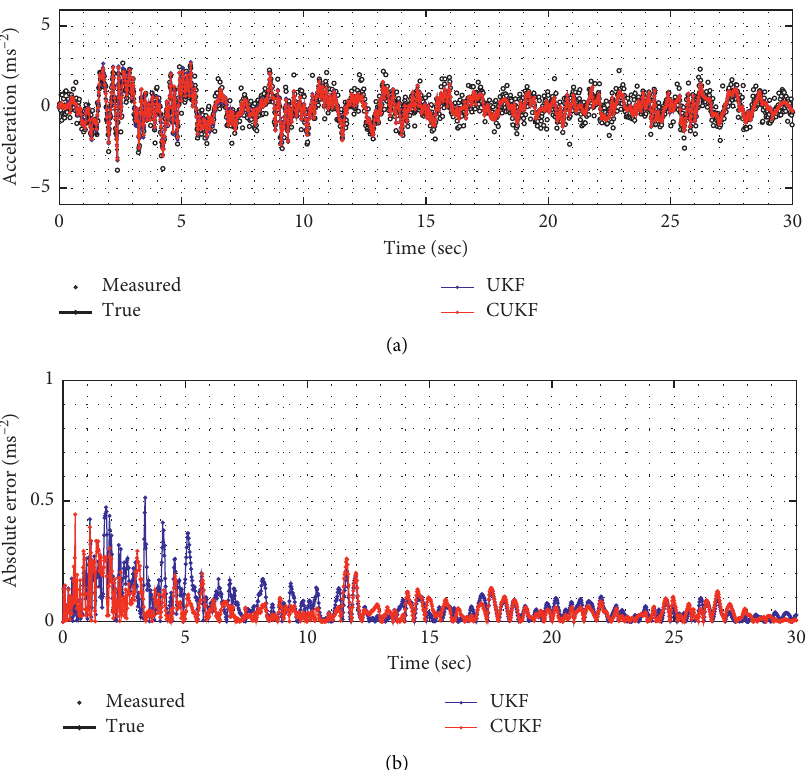
Figure 6: Comparison of acceleration time history results for Example 3 identified by the UKF and CUKF (a) and the corresponding absolute errors